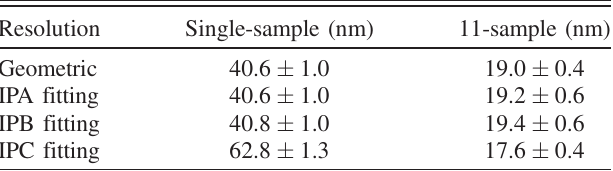
TABLE III. The best single-sample and integrated-sample resolution measurements for the geometric and fitting methods.